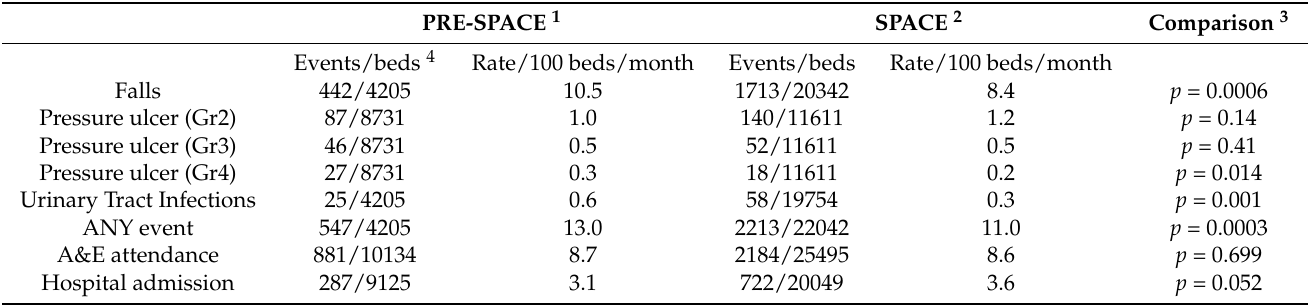
Table 4. Pre- and post-SPACE avoidable harms, A&E attendance, hospital